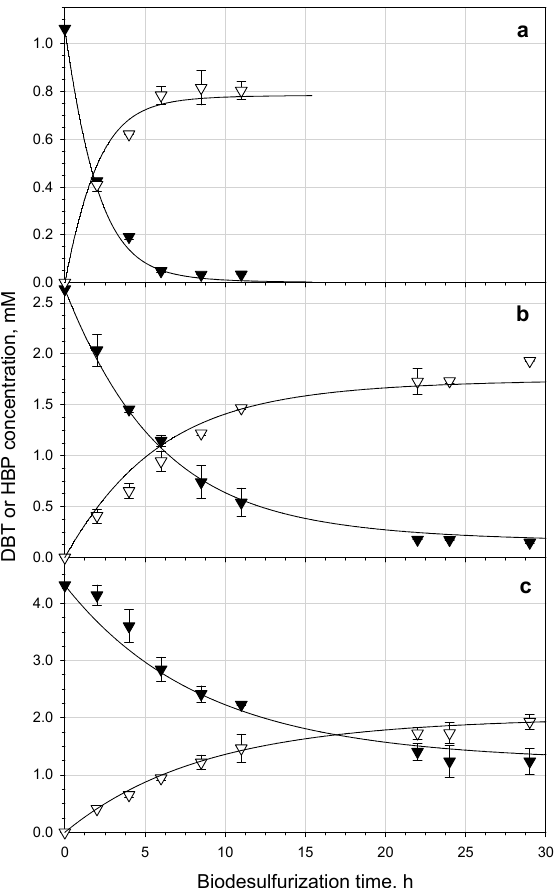
Figure 9. Time course of biodesulfurization of DBT and production of 2-HBP by R. erythropolis IGTS8 resting cells at different initial DBT concentrations: ( a ) 1.1 mM DBT, ( b ) 2.6 mM DBT, and ( c ) 4.3 mM DBT. Symbols : DBT ( θ ), 2-HBP ( σ ). Solid lines represent model fitting (Equations (6) and (7)).